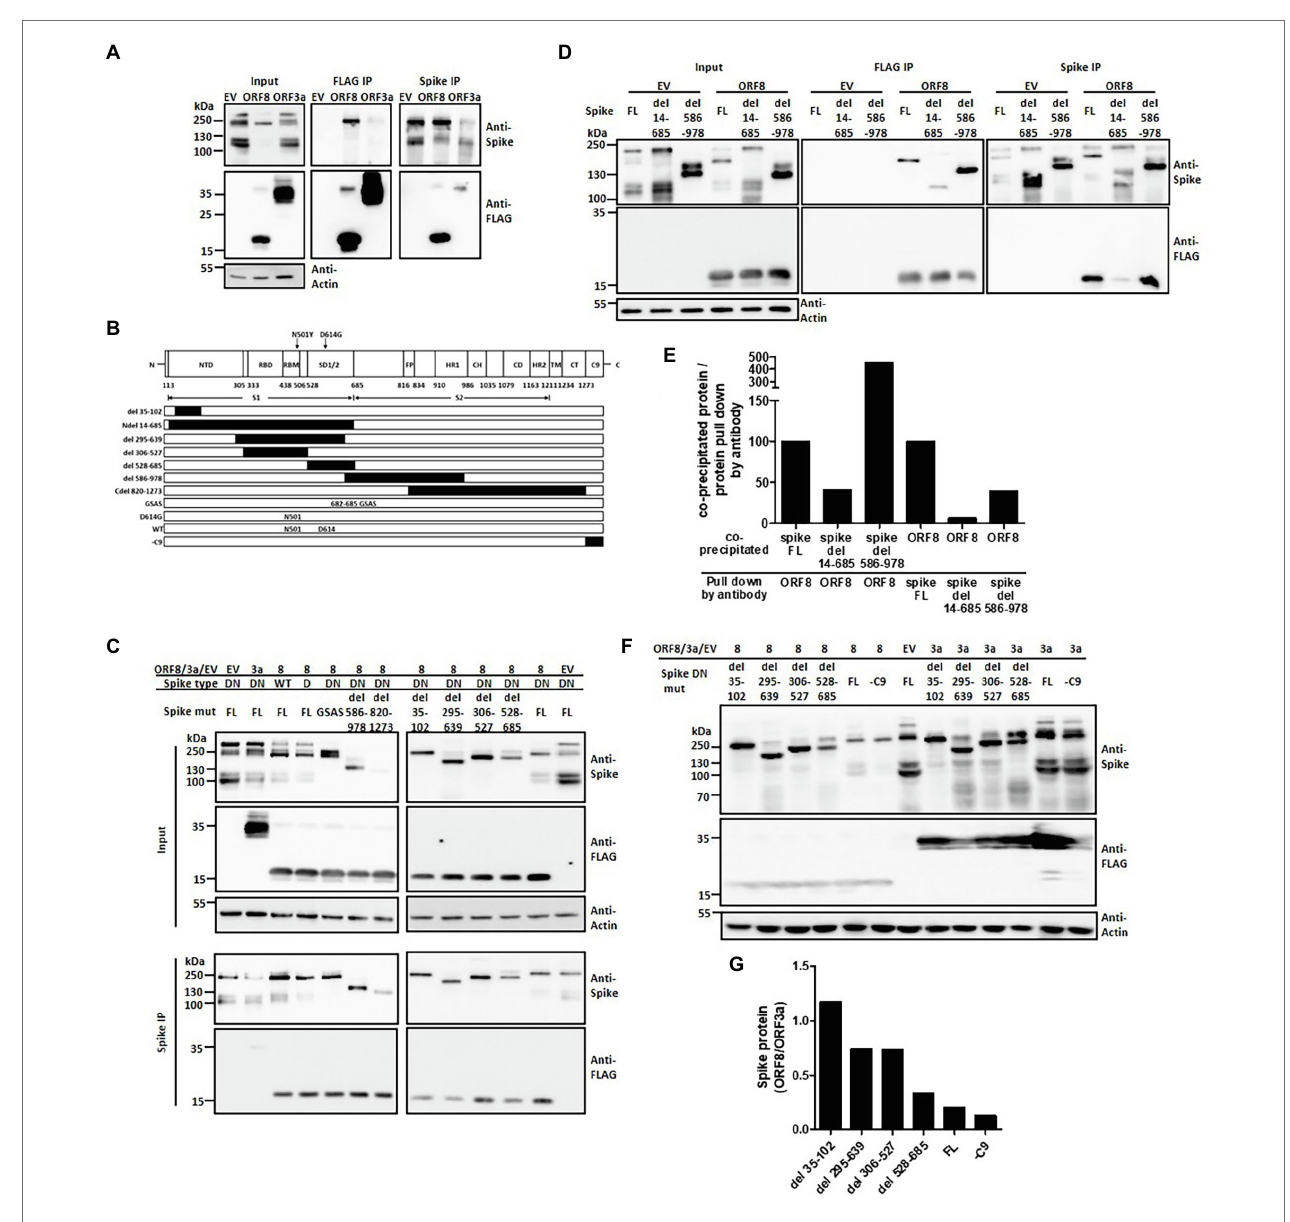
FIGURE 3 | ORF8 interacts with the spike protein at different domains. HEK293T cells were cotransfected with the plasmids described in each figure, and the cell lysates were prepared and subjected to immunoprecipitation using an antibody against the FLAG tag or spike protein. In all following immunoprecipitation results, immunoblots were obtained using total cell lysates (input), and the proteins were pulled down by Protein G Dynabeads conjugated with the indicated antibody (IP). (A) Representative immunoprecipitation data obtained using either anti-FLAG or anti-spike antibodies are shown. EV: empty vector. (B) A series of spike proteins with different mutations or deletions were constructed for the experiments described in the cartoon figure. Schematic figure presenting the domain arrangement of the spike protein was adapted from Duan et al. with few modifications. NTD: N-terminal domain; RBD: receptor-binding domain; RBM: receptor-binding motif; SD1/2: subdomain 1 and 2; FP: fusion peptide; HR1 and HR2: heptad repeat 1 and 2; CH: central helix; CD: connector domain; TM: transmembrane domain; CT: cytoplasmic tail; C9: C9 tag. The black boxes shown in this figure represent the deleted regions of the spike protein. (C) A series of immunoprecipitation experiments focusing on different spike variants or deletions were performed using a polyclonal anti-spike antibody. (D) An immunoprecipitation experiment was performed using the full-length or the mutated spike protein with deletion of the S1 (del 14-685) or S2 region (del 586-978) was shown. (E) Meanwhile, the intensity of interaction between ORF8 with different mutations of the spike proteins shown in (D) was evaluated by the evaluation of the ratio between the protein level of the co-precipitated protein vs. the protein directly pull down by the indicated antibody. (F) The spike protein expression levels were compared between ORF8- and ORF3-transfected cells by using immunoblotting and (G) the spike protein expression level in between both groups was evaluated by using the ImageJ software. Abbreviations of the spike mutants shown in (C–F) are as following: DN: D614G/N501Y; D: D614G; GSAS: point mutations created at 682–685 amino acids; FL: full length; -C9: spike protein without C9 tag at its C-terminal. And del 14-685, del 586-978, del 35-102, del 295-639; del 306-527; del 528-685 represent the deletion regions of the spike